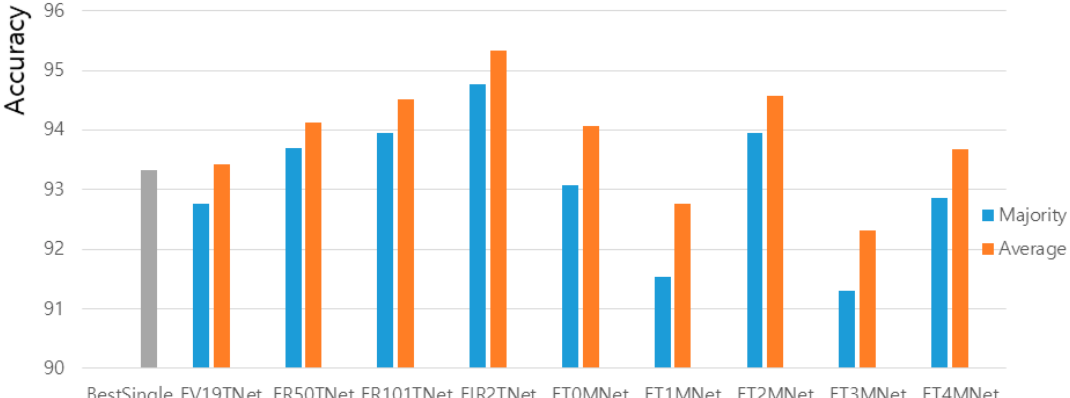
Figure 24. Performance comparison by various ensemble deep models.